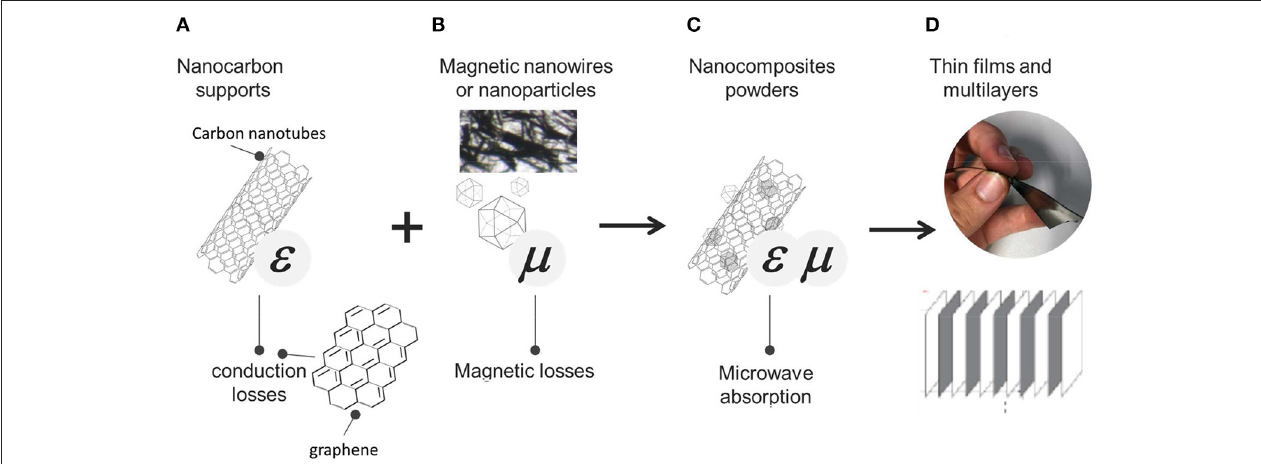
FIGURE 1 | Illustration of the approach: conductive inclusions (A) , responsible for dielectric constant and conductivity, and magnetic nanostructures (B) are combined to induce microwave absorption (C) and are dispersed in polymer matrix, to form thin films that are stacked to form multilayers (D) . Considered polymer is polycarbonate well known for its stiffness allowing flexibility.